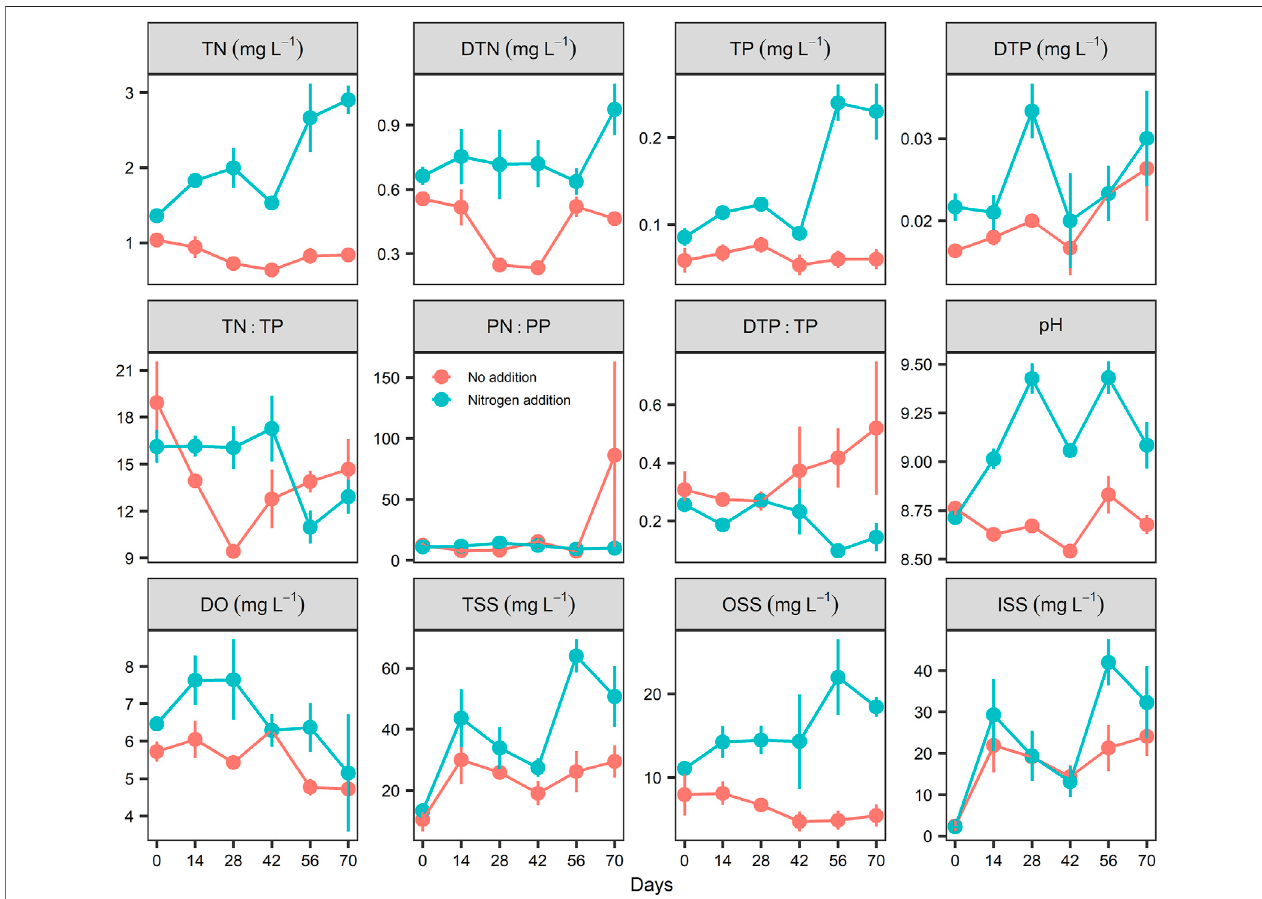
FIGURE 2 | Time series of total nitrogen (TN), total phosphorus (TP), dissolved total nitrogen (DTN), dissolved total phosphorus (DTP), TN: TP, PN: PP, DTP: TP, pH, dissolved oxygen (DO), total suspended solids (TSS), organic suspended solids (OSS), and inorganic suspended solids (ISS) in the two nitrogen treatments. Values are mean ± SE ( n (cid:2)